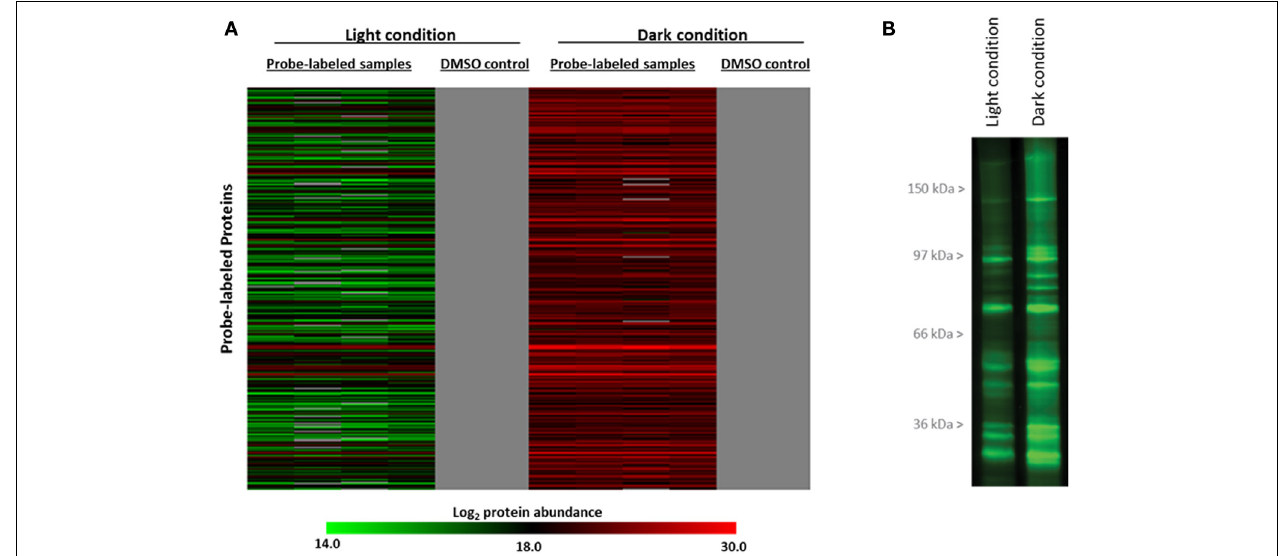
FIGURE 2 | (A) Condition-dependent changes of in vivo labeling with IAM- and Mal-RPs in 300 redox-sensitive proteins identified. The heat map shows redox sensitive proteins exhibited increased probe labeling after incubation in the dark (red) relative to the light (green) condition in live-cell labeled Synechococcus 7002. Scale represents log2 of protein abundance and ranges from low (green) to high (red)